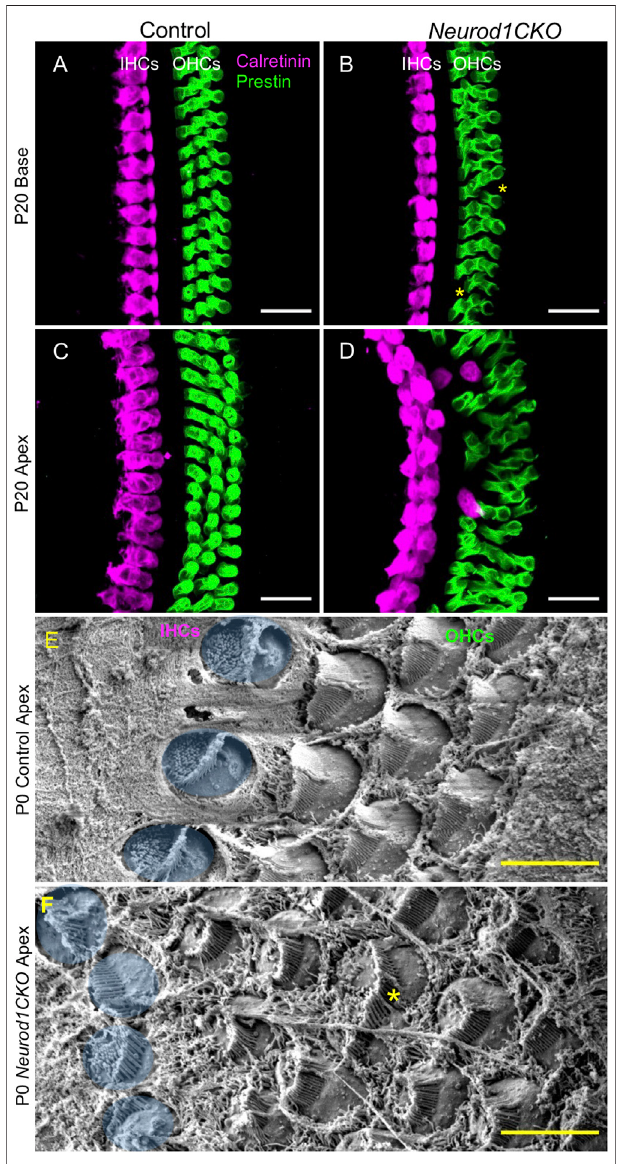
FIGURE 9 | The sensory epithelium of the cochlea is disorganized in Neurod1CKO . (A – D) In contrast to adult controls, the sensory epithelium in the base of Neurod1CKO has missing cells (asterisks), as shown by confocal images of immunolabeling with inner hair cell (IHC) marker calretinin and with prestin, a marker of outer hair cells (OHCs). Ectopic (transdifferentiated) IHCs located among OHCs, two IHC rows, and multiple OHC rows are found in the Neurod1CKO apex compared to the single row of IHCs and three rows of OHCs in control cochlea. (E , F) Scanning electron microscopy revealed abnormalitiesinthecellularcharacteristicsandhaircellstereociliaorganization in Neurod1CKO . Compared to the control epithelium, HCs in the Neurod1CKO cochlea differed in their size (asterisk marks a fused cell), the orientationofcells,andstereocilia.IHCsarepseudocolouredblue.Scalebars: 20 µm (A – D) ; 5 μ m (E , F)